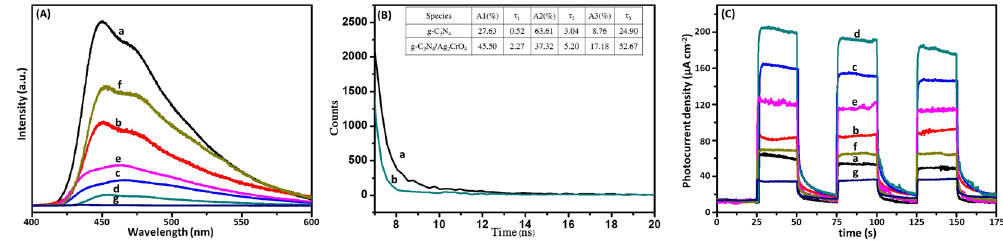
Figure 7. ( A ) Photoluminescence spectra of (a) g-C 3 N 4 , (b) g-C 3 N 4 /Ag 2 CrO 4 (9.1%), (c) g-C 3 N 4 /Ag 2 CrO 4 (16.7%), (d)